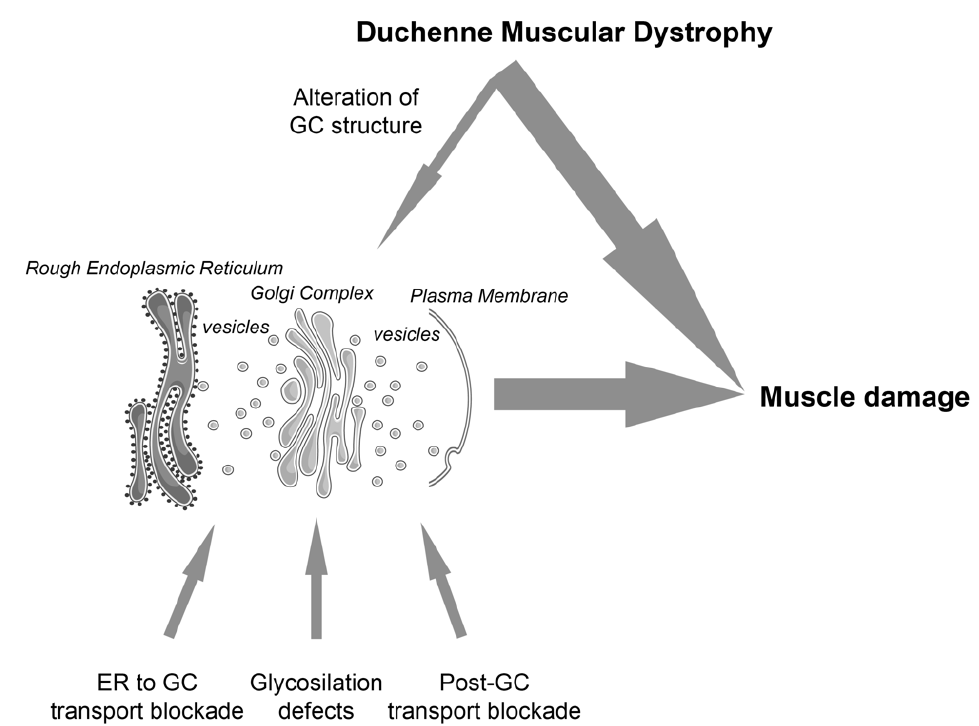
Figure 1. The GC is a central organelle in the biosynthetic pathway. We suggest that GC integrity and functionality contributes to the pathological mechanisms of muscular dystrophies via direct (bottom arrows highlight three different conditions that affect protein traffic in the context of muscular dystro- phies: ER to GC blockade [5,21,22]; glycosylation defects [14,16]; post GC transport blockade [18,19]) or secondary mechanisms (top arrow; [30–32]), contributing to muscle damage. The figure was partly generated using Servier Medical Art, provided by Servier, licensed under a Creative Commons Attribution 3.0 unported